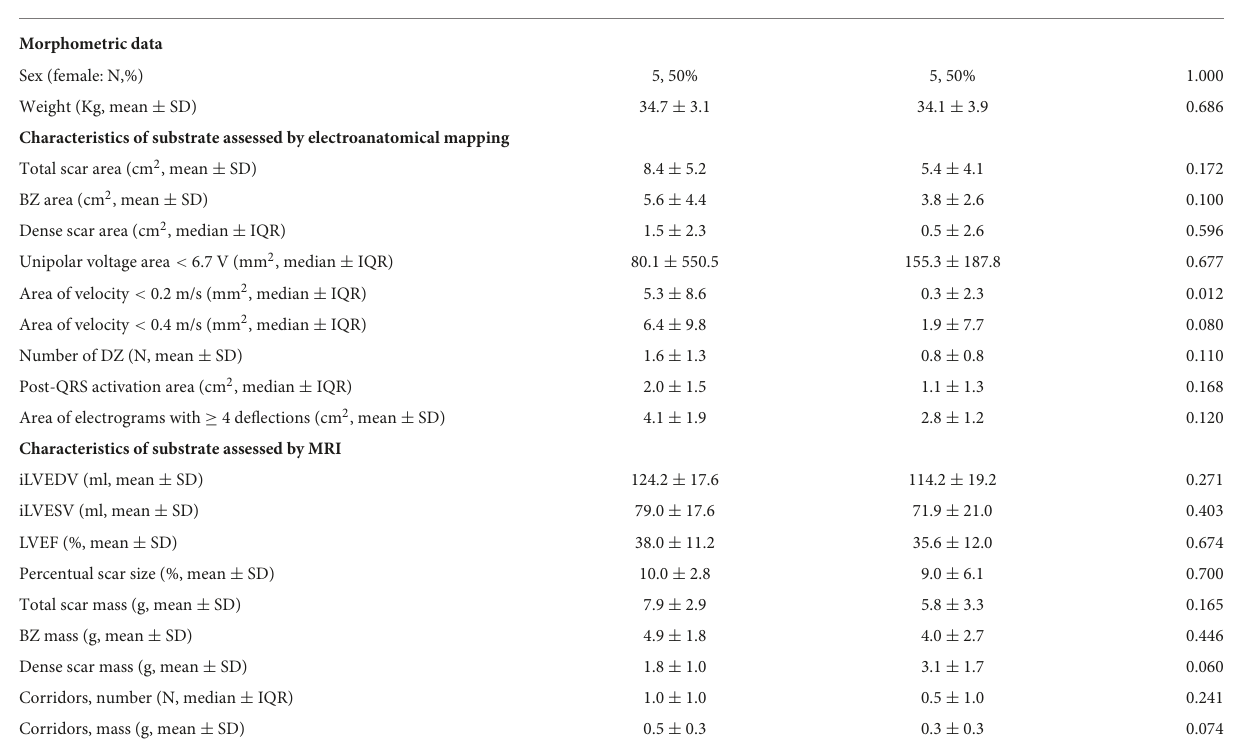
TABLE 1 Baseline characteristics of AGTP and sham-surgery animals.